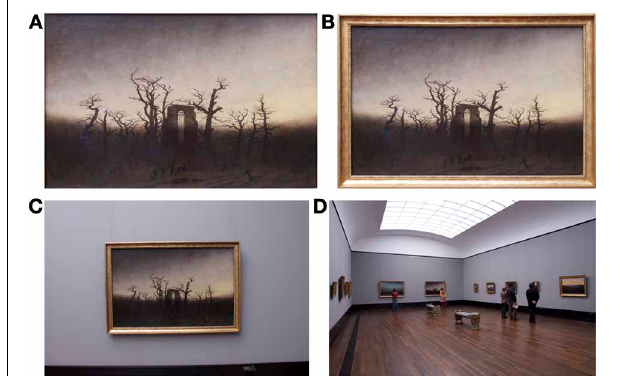
FIGURE 3 | Image categories analyzed. Images of a painting without frame [ P image ; (A) ], of the painting with its frame [ PwF image ; (B) ], of a scene containing the painting, its frame and the immediate surround [ PwF/S image ; (C) ], and a museum scene [ MSc image ; (D) ] are shown. The painting by Caspar David Friedrich is entitled “Abbey Among Oak Trees” (1809/10) and was reproduced with kind permission from ©Staatliche Museen zu Berlin, Nationalgalerie.